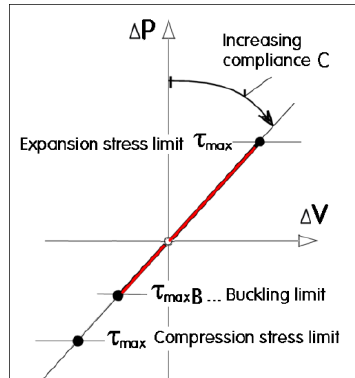
Fig. 14. Pressure difference acting on the capsule shell walls due to thermal volume change may assume a position everywhere on the red colour compliance line. This is limited by the expansion or compression maxima of the maximum tensile stress of the